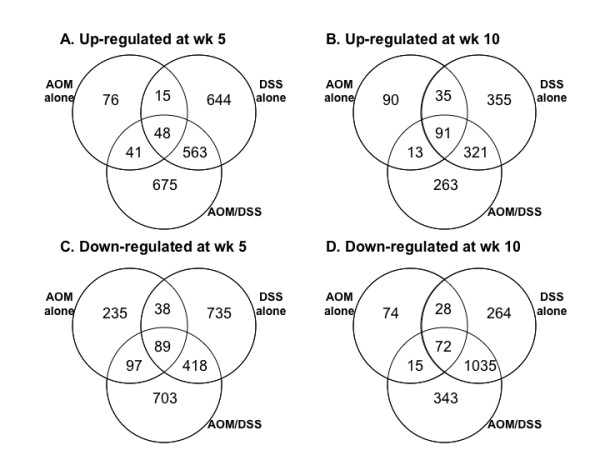
Venn diagrams. The numbers of up-regulated genes at wk 5 (A) and wk 10 (B), and down-regulated genes at wk 5 (C) and at wk 10 (D) in the colonic mucosa of mice in the AOM alone, DSS alone, and AOM/DSS groups. The numbers indicate the numbers of genes with their expression by over 2-fold up-regulated or by less 1/2-fold down-regulated between the treated (AOM-, DSS- or AOM/DSS) groups and untreated control group.